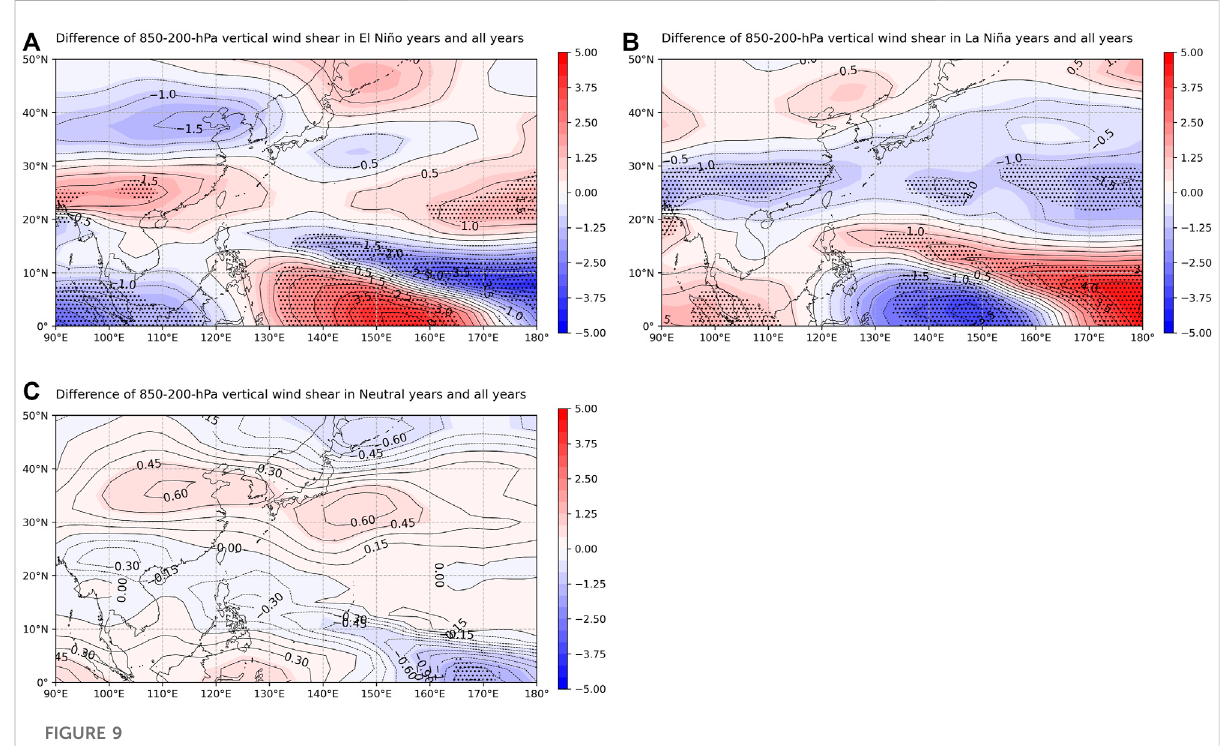
FIGURE 9 Same as Figure 8, but for 850-200-hPa vertical wind